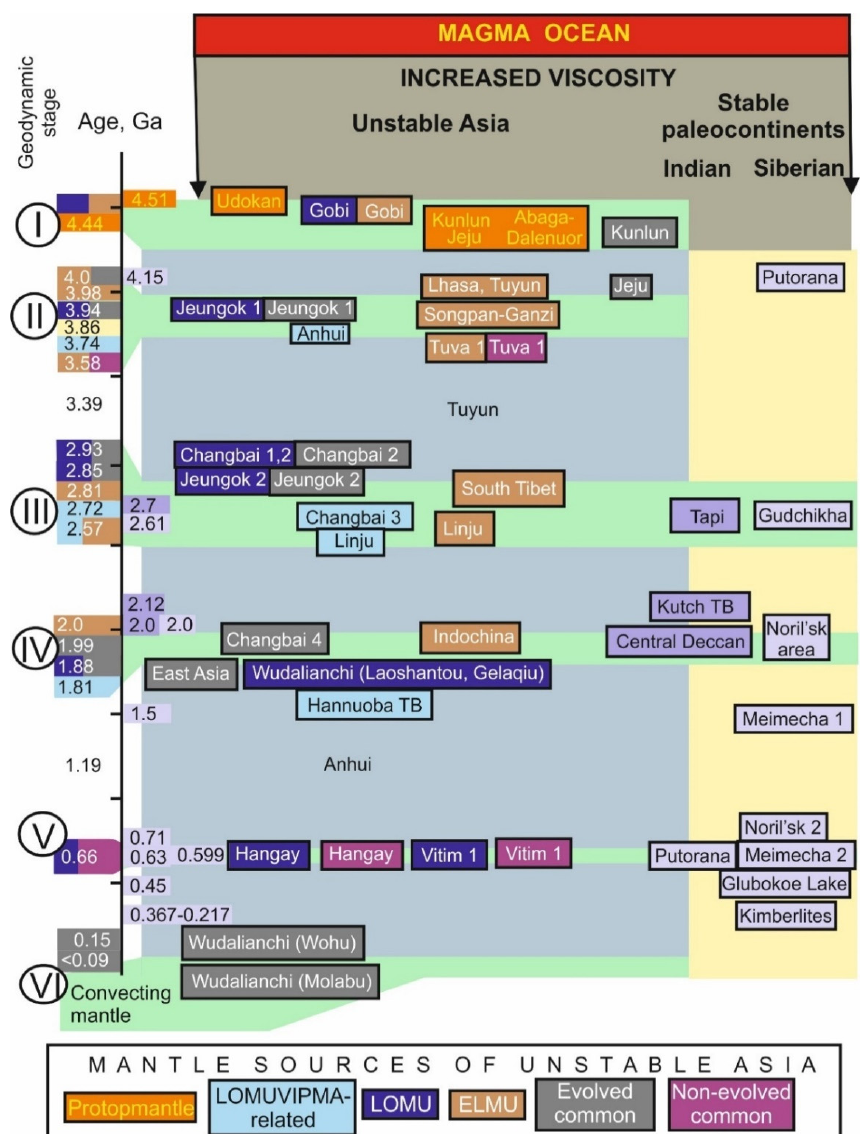
Figure 4. Correlation of Pb isotope ages of sources for late Phanerozoic melting anomalies in the viscous mantle of unstable Asia and Indian and Siberian paleocontinents. The viscous mantle sources of unstable Asia are divided in terms of the primary origin of the viscous mantle from the magmatic ocean (protomantle, LOMUVIPMAR-related), µ signatures (LOMU, ELMU), and the nature of common components (evolved, non-evolved). Roman numerals in circles indicate the six time intervals of the viscous mantle generation in unstable Asia. No Pb isotope ages were determined in cases of isometric data-point distributions, so such units as the Hannuoba TEPB (transitional, evolved, primitive basalts), Kutch AB (alkali basalts), Wulanhada, Oka, Vitim 2, Vitim 3, and Xiaoguli are not shown on the